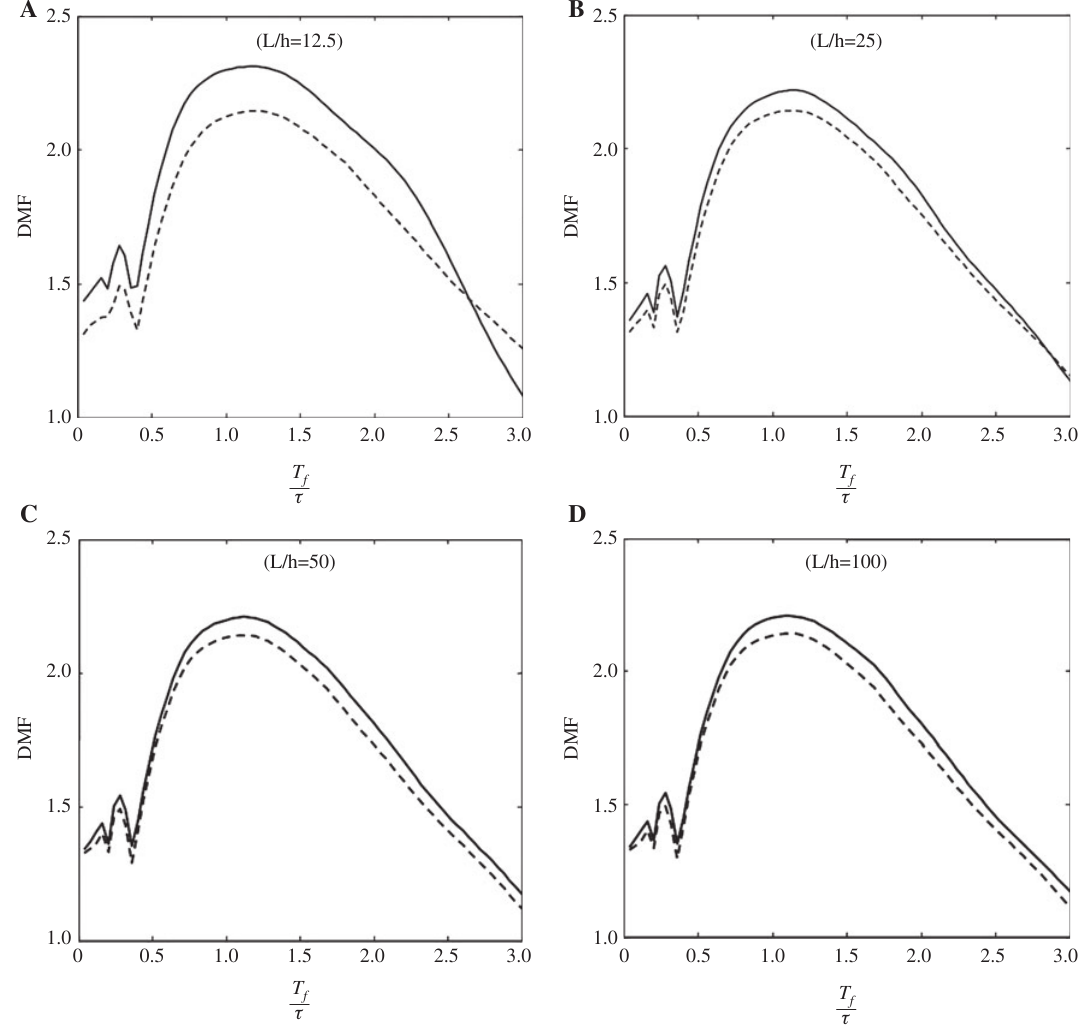
Figure 8 Effect of shear deformation on the DMF vs. T laminated theory)